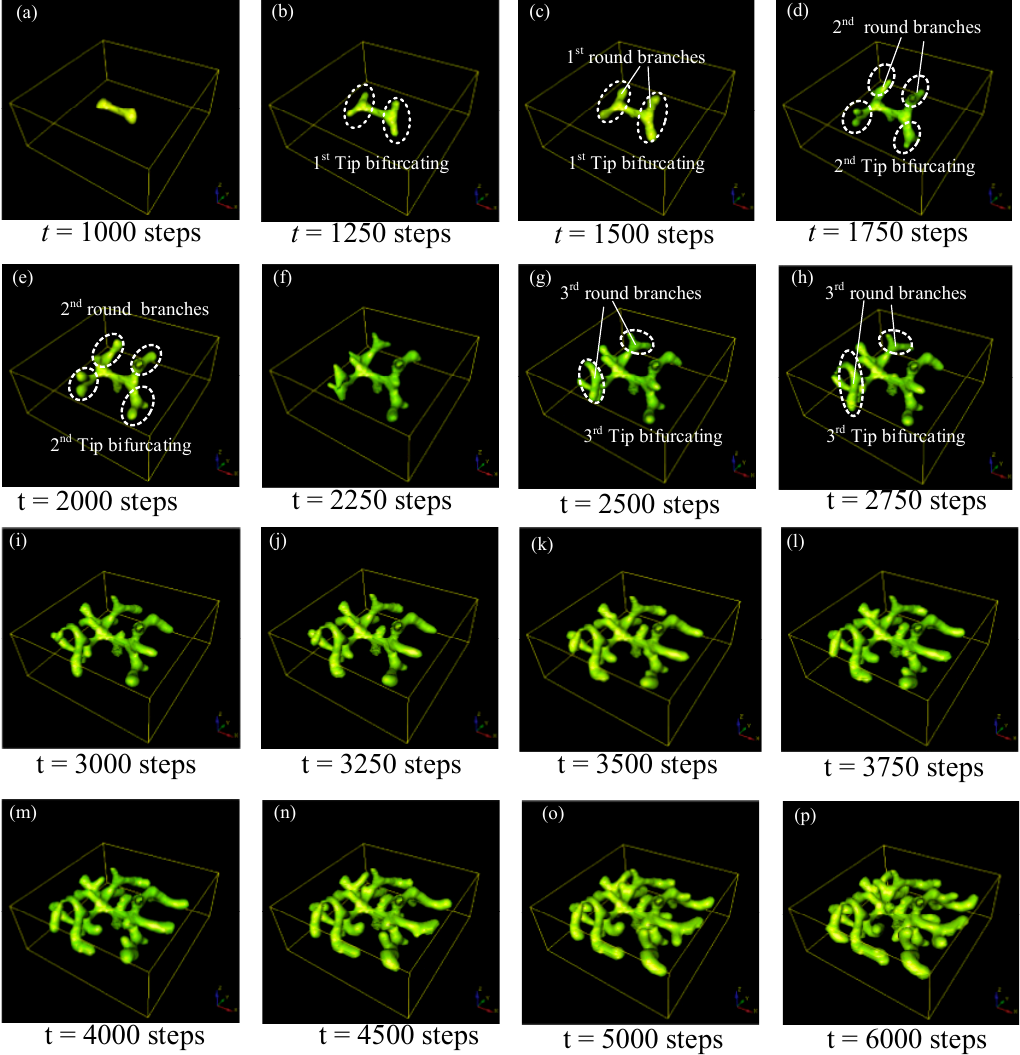
Figure 5. Simulation results for tip-splitting behaviors in 3D. The presented structure is the spatial distribution of the cellular differentiation marker Y . The numbers under the images denote the step numbers in the simulation. Parameters: c = 0.04, µ = 0.38, v = 0.04, ρ A = 0.03, ρ H = 0.0001, c 0 = 0.02, γ = 0.03, ε = 0.042, d = 0.008, e = 0.1, f = 10, D A = 0.1, D H = 0.26, D S = 0.06.